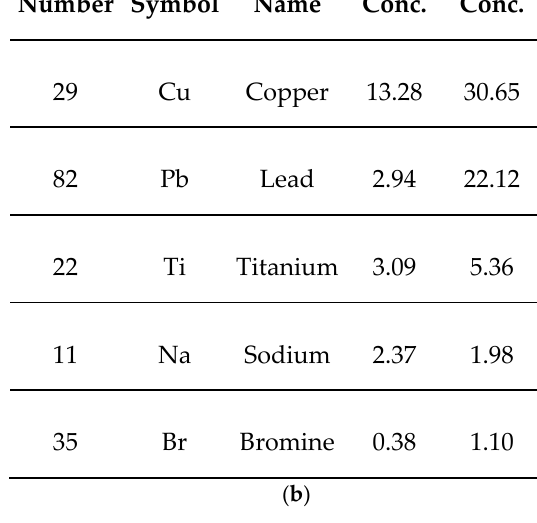
Figure 15. SEM micrograph of the edge of the bullet hole in the steel plate from the side of the projectile exit ( a ) and listing the most important chemical elements on the analyzed surface ( b ) determined by SEM ‐ EDS (FOV: 86.6 μ m, Mode: 15 kV—Image, Detector: SED).